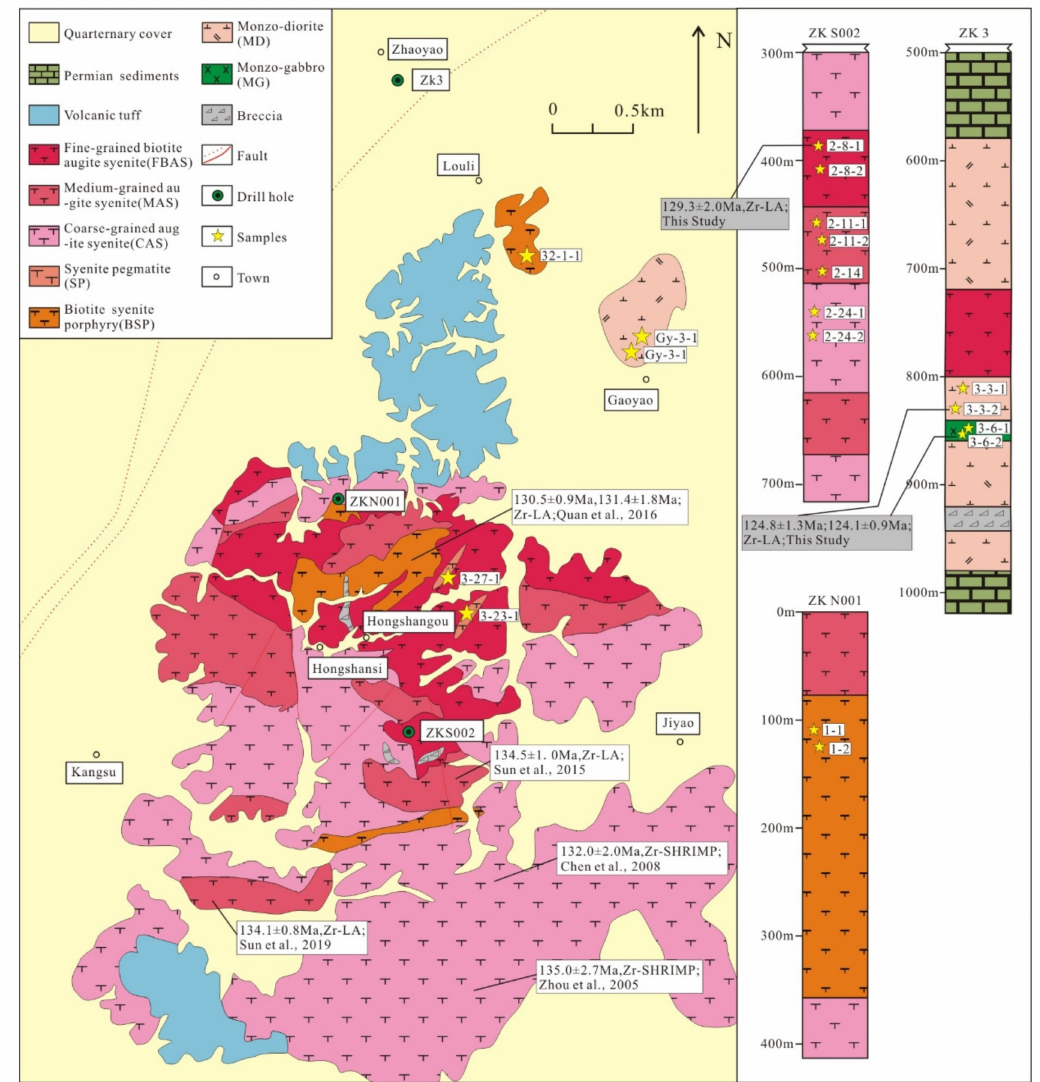
Figure 2. Geological map of the Hongshan complex and the locations of the samples(modified after No. 1 Geological Team of Hebei Bureau of Geological Exploration and